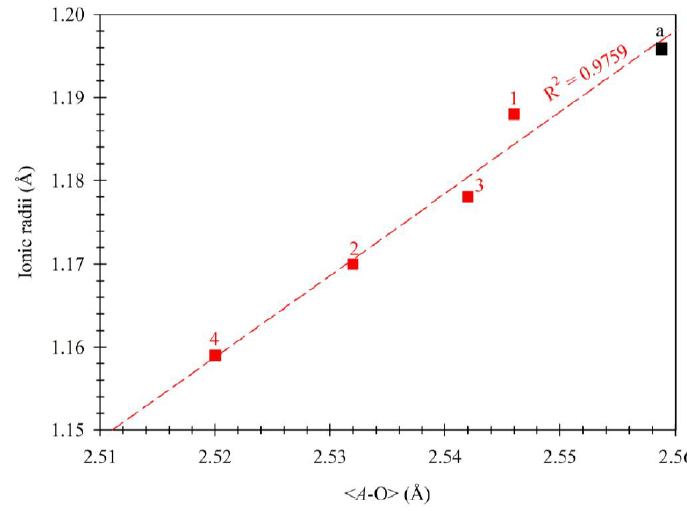
Figure 4. Average < A -O > distances vary linearly with the weighted average ionic radii of the A site cations. The red dashed linear line is fitted to data from this study, whereas “a” is from Reference [8]. The ionic radii for A site cations control the average < A -O > distances in monazite. The A ‐ P cation–cation distance is shorter than the A ‐ P ʹ distance (Figure 5). The A ‐ A distances vary from 4.0228(9) (sample 4) to 4.0628(3) Å (sample 1). The cation–cation distances vary linearly with the weighted average ionic radii of A site cations (Figure 5). The two A -P distances for synthetic light rare earth phosphates vary linearly with the ionic radii of light Ln 3+ cations, but the degree of variations di ff er [8]. This study shows that the degree of variations of the two A -P distances are not significant, whereas the A - A distances show significant variations (Figure